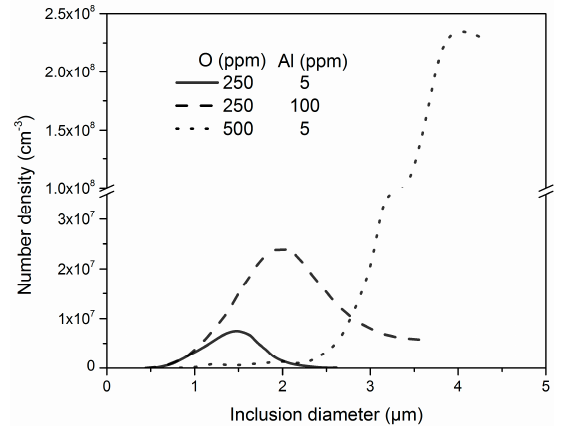
Figure 9. Effect of O and Al content on Al 2 O 3 size distribution [45].